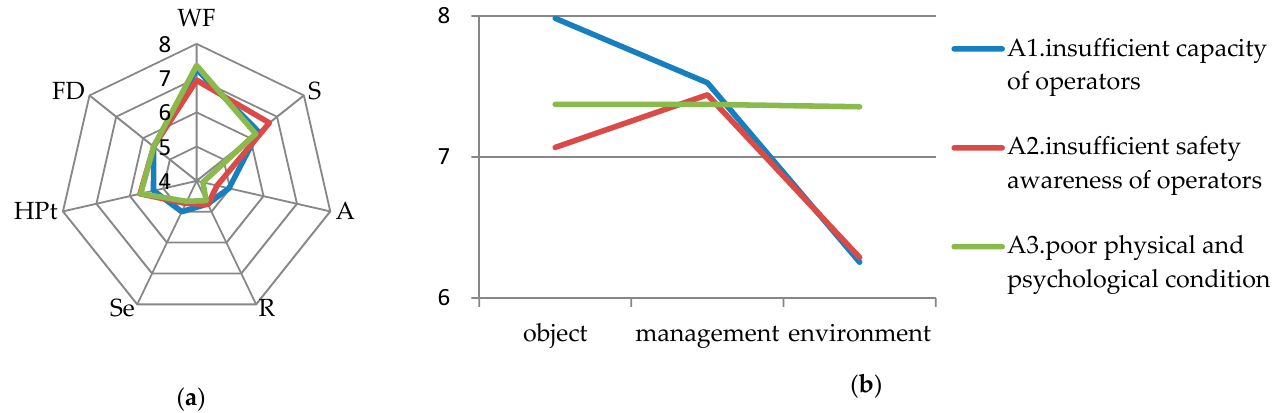
Figure 1. ( a ) Parameters’ scores for human unsafe behaviors; ( b ) detailed scores of worsening factors (WF) for human unsafe behaviors.